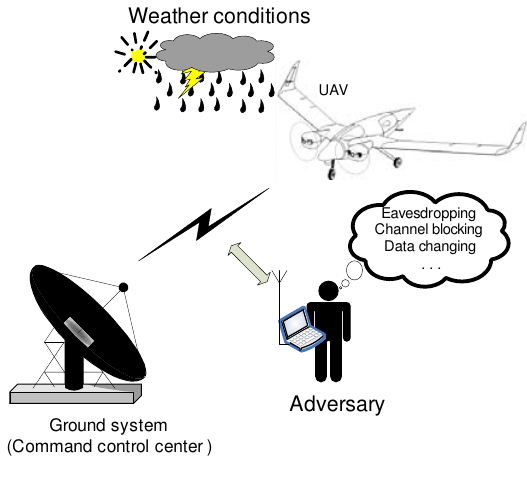
Fig 2. Potential